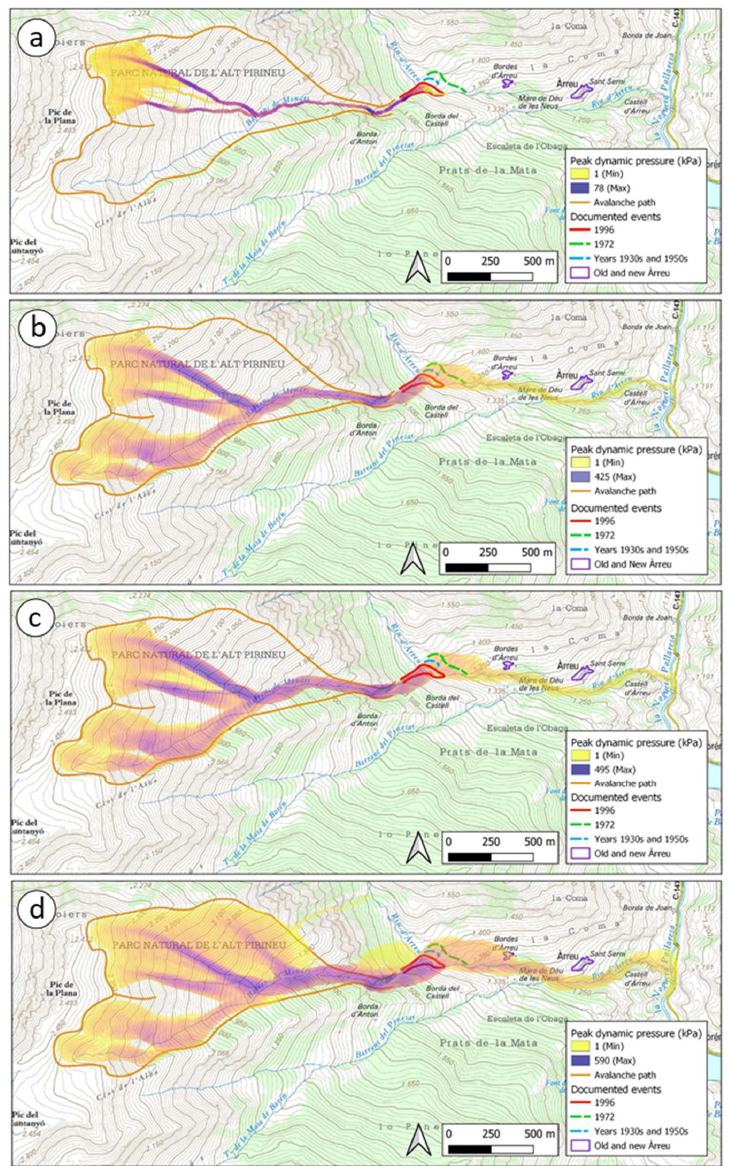
Figure 14. Dense flow avalanche (DFA) dynamic simulations with SAMOS-AT: ( a ) Simulation of the 1996 avalanche, considering the release areas A1, A2, and A3, as was observed on that occasion. A dense flow with a volume of 7.1 × 10 3 m 3 was considered; ( b ) simulation of an event released from the medium-frequency areas A5 and B4, with a release snow depth corresponding to a return period of 30 years (192 × 10 3 m 3 ), and considering the occurrence of a previous avalanche similar to the one in 1996. The avalanche does not reach old Àrreu, but flows along Àrreu river to the main valley; ( c ) simulation of an event including the medium-frequency release areas A5 and B4, with a release snow depth corresponding to a return period of 300 years (260 × 10 3 m 3 ), and considering the occurrence of a previous avalanche like the one of 1996. The avalanche does not reach old Àrreu, but again flows along Àrreu river to the main valley; ( d ) simulation of an event including the full extent of starting zone A and B and a snow depth corresponding to a T30 return period (603 × 10 3 m 3 ) and considering the occurrence of a previous avalanche like the one in 1996. The second avalanche reaches old À rreu with peak pressure values of 150 kPa at the western boundary of the